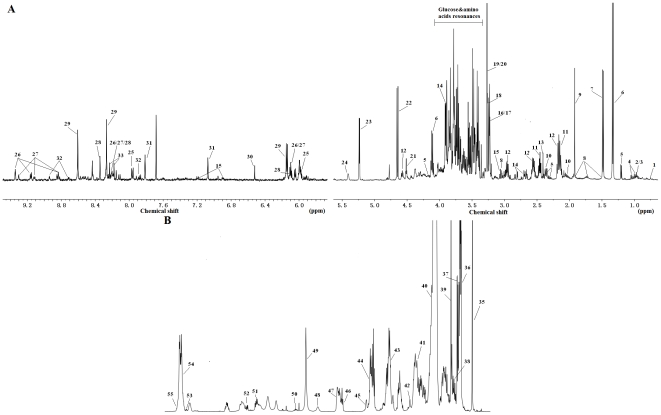
High resolution 500 MHz single pulse 1H-NMR spectra of liver tissue extracts from control hamsters.(A): 1H-NMR spectrum of liver tissue aqueous extracts from control hamsters. (B): 1H-NMR spectrum of liver tissue chloroform/methanol extracts from control hamsters. Signal assignment: 1, Bile acid C18 methyls; 2, Isoleucine; 3, Leucine; 4, Valine; 5, β-Hydroxybutyrate; 6, Lactate; 7, Alanine; 8, Lysine; 9, Acetate; 10, Glutamate; 11, Glutamine; 12, Glutathione; 13, Succinate; 14, Aspartate; 15, Tyrosine; 16, Choline; 17, Phosphocholine; 18, Glycerophosphorcholine; 19,Trimethylamine-N-oxide; 20, Betaine; 21, N-methyl nicotinamide; 22, β-Glucose; 23, α-Glucose; 24, Glycogen; 25, UDP-Glucose; 26, NAD+; 27, NADP+; 28, Inosine&adenosine; 29, AMP; 30, Fumarate; 31, Histidine; 32, Nicotinurate; 33, Adenine; 34, Adenosine; 35, Cholesterol (C18H3); 36, Fatty acid residues (ω-CH3); 37, Cholesterol (C26H3, C27H3, C21H3); 38, Fatty acid residues (ω-CH3 of total omega-3 fatty acid); 39, Cholesterol (C19H3); 40, Fatty acid residues ((CH2)n); 41, Fatty acid residues (COCH2-CH2); 42, Fatty acid residues (-CH2 of ARA+EPA); 43, Fatty acid residues (CH2-CH = ); 44, Fatty acid residues(-CO-CH2); 45, Fatty acid residues (α and β CH2 of DHA); 46, Fatty acid residues (-CH = CH-CH2-CH = CH-of linoleic acid); 47, Fatty acid residues (CH = CH-CH2-CH = CH)n, n>1; 48, CH2-NH2 of PE; 49, N+(CH3)3 (PC and SM); 50, Cholesterol (C3H); 51, Triglycerides (C1H and C3H of glycerol); 52, Triglycerides (C1H and C3H of glycerol); 53, Triglycerides (C2H of glycerol); 54, Fatty acid residues (CH = CH); 55, Cholesterol (C6H). ARA, Arachidonic acid; EPA, Eicosapentaenoic acid; DHA, Doco- sahexaenoic acid; PE, Phosphatidylethanolamine; PC, Phosphatidylcholine; SM, Sphingo- myelin.